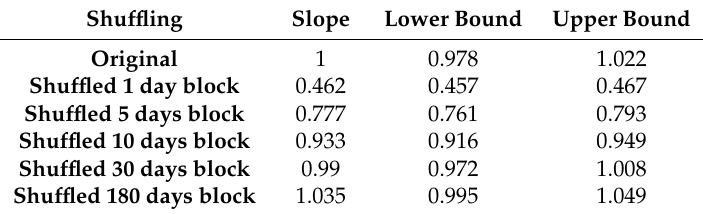
Figure 8. GEV fit of annual maxima discharges of the different meteorological shuffling experiments. The points (colored) represent the distribution and the solid (colored) line represent the linear fit on a logarithmic scale. Table 2. Slope of the GEV shown in Figure 8, and lower and upper bound of the linear fit. Results are normalized relative to the original unshuffled